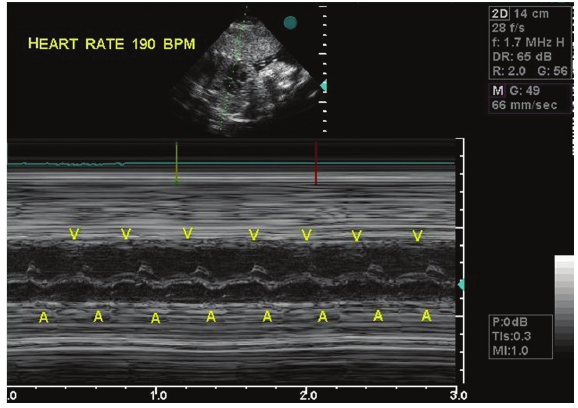
Figure 2: M-mode fetal echocardiogram shows sinus tachycardia of 180–190 per